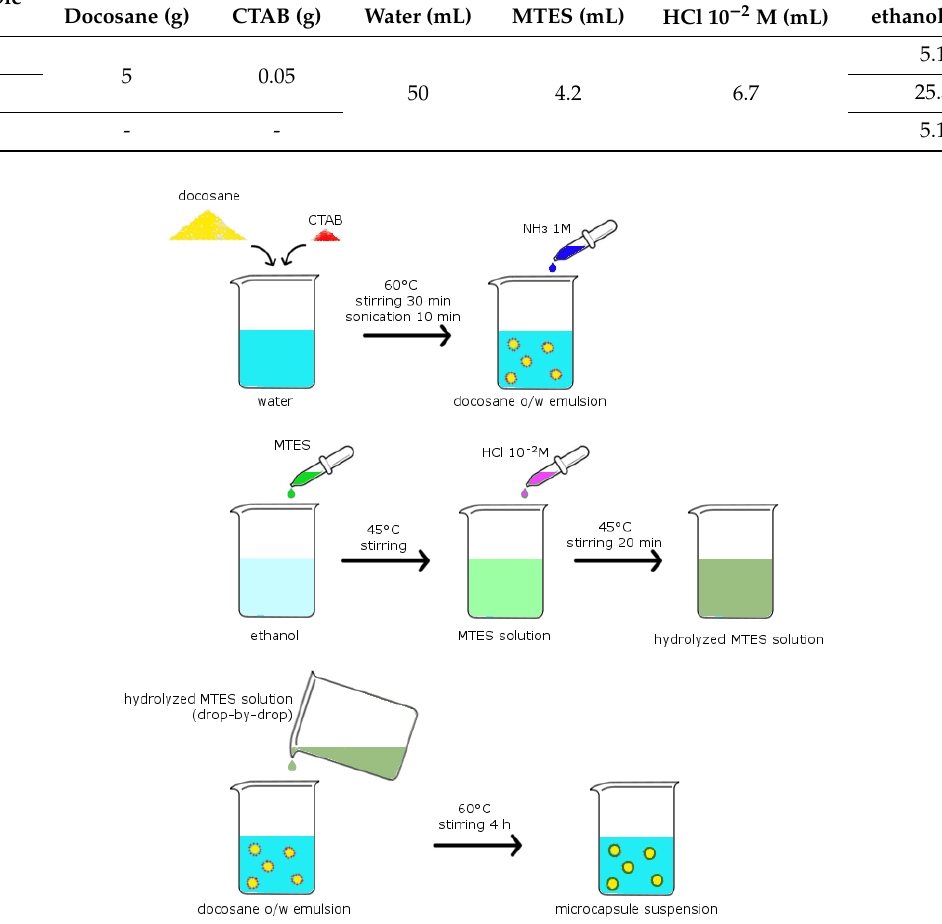
Figure 1. Experimental steps followed for the synthesis of the microcapsules.